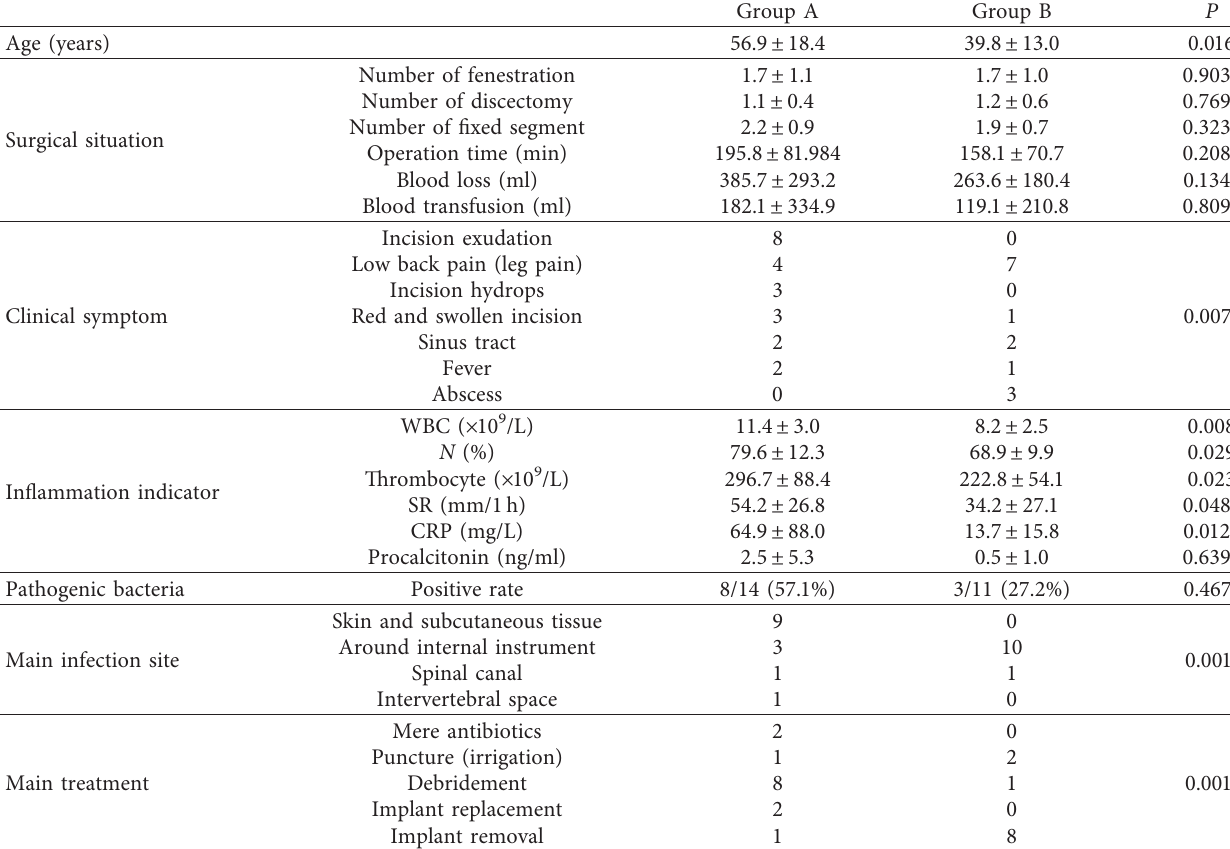
Table 1: Comparison of the observational indicators between Groups A and